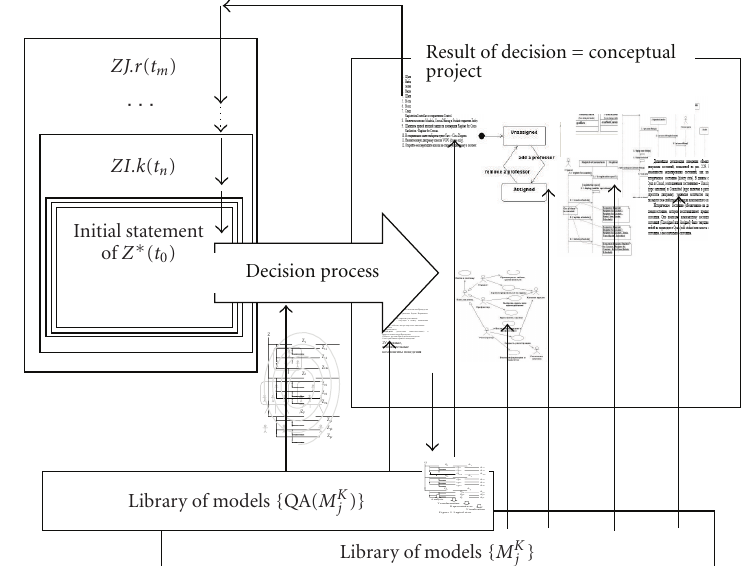
Figure 12: Scheme of method.